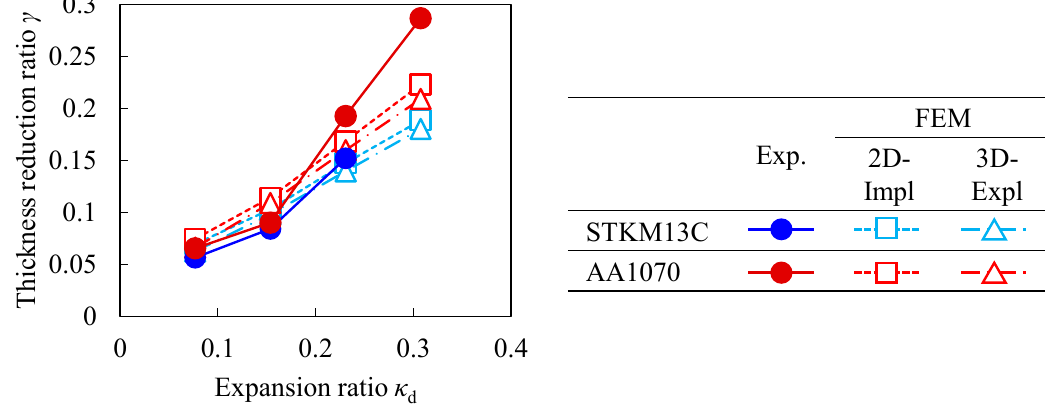
Figure 16. E ff ect of expansion ratio κ d on thickness reduction ratio γ . Figure 16. Effect of expansion ratio κ d on thickness reduction ratio γ .